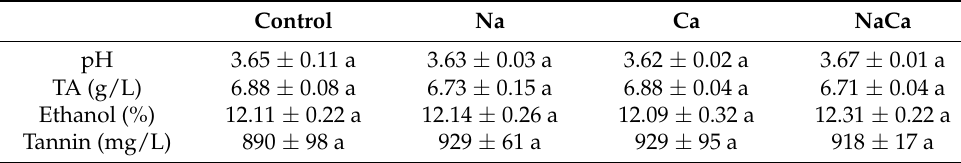
Table 1. Oenological parameters and tannins measured in resultant